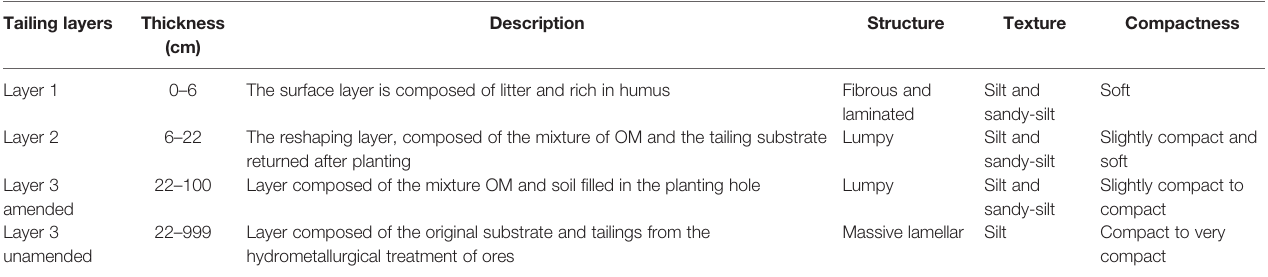
TABLE 1 | Pro fi le layer